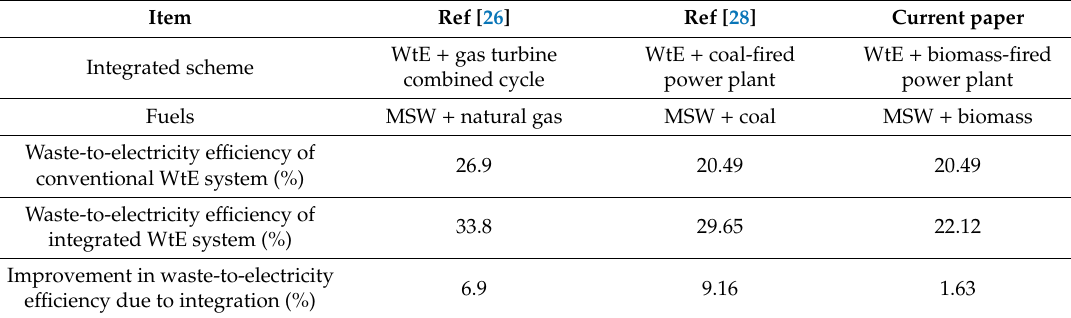
Table 10. Performance comparison of the WtE systems integrated with various power